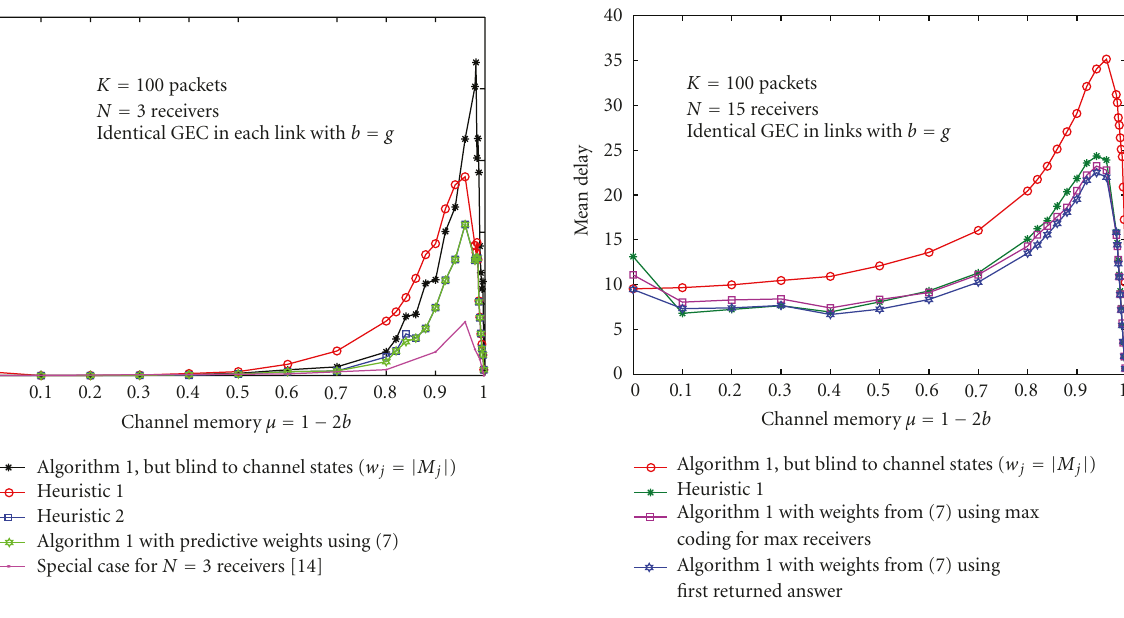
Figure 9: Delay performance of di ff erent algorithms in Gilbert- Elliott channels. The maximum number of recursions for Heuristic 2 is set to 100. By predicting next channel states and defining packet weights accordingly (see (7)), one can achieve considerably lower delays.